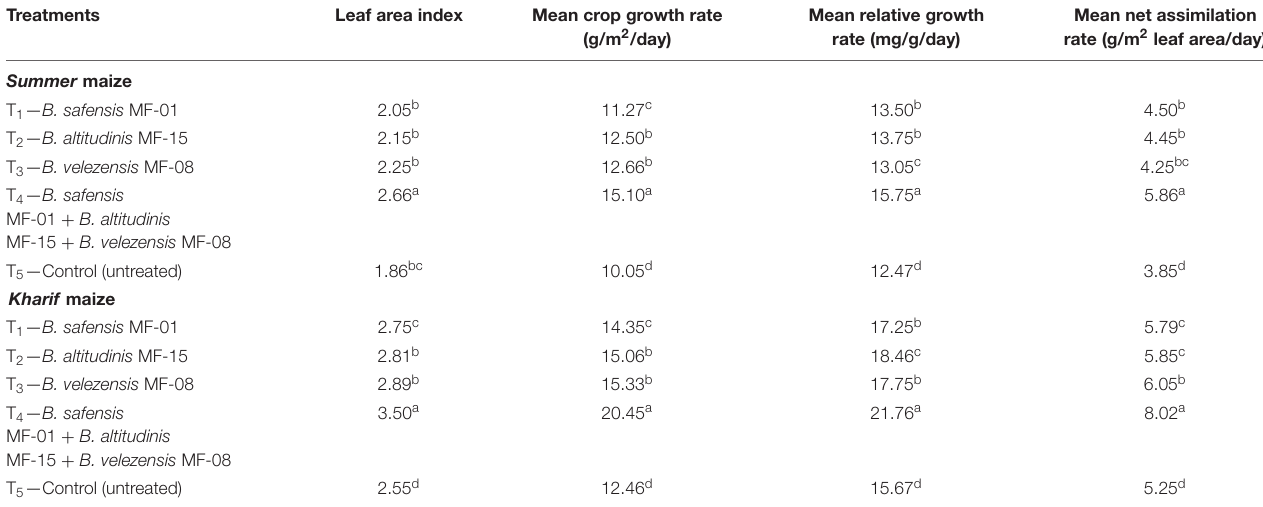
TABLE 7 | Effects of seed biopriming and microbial intervention on physiological traits in maize grown in Summer and Kharif season under field conditions at 45 days of sowing. Treatments